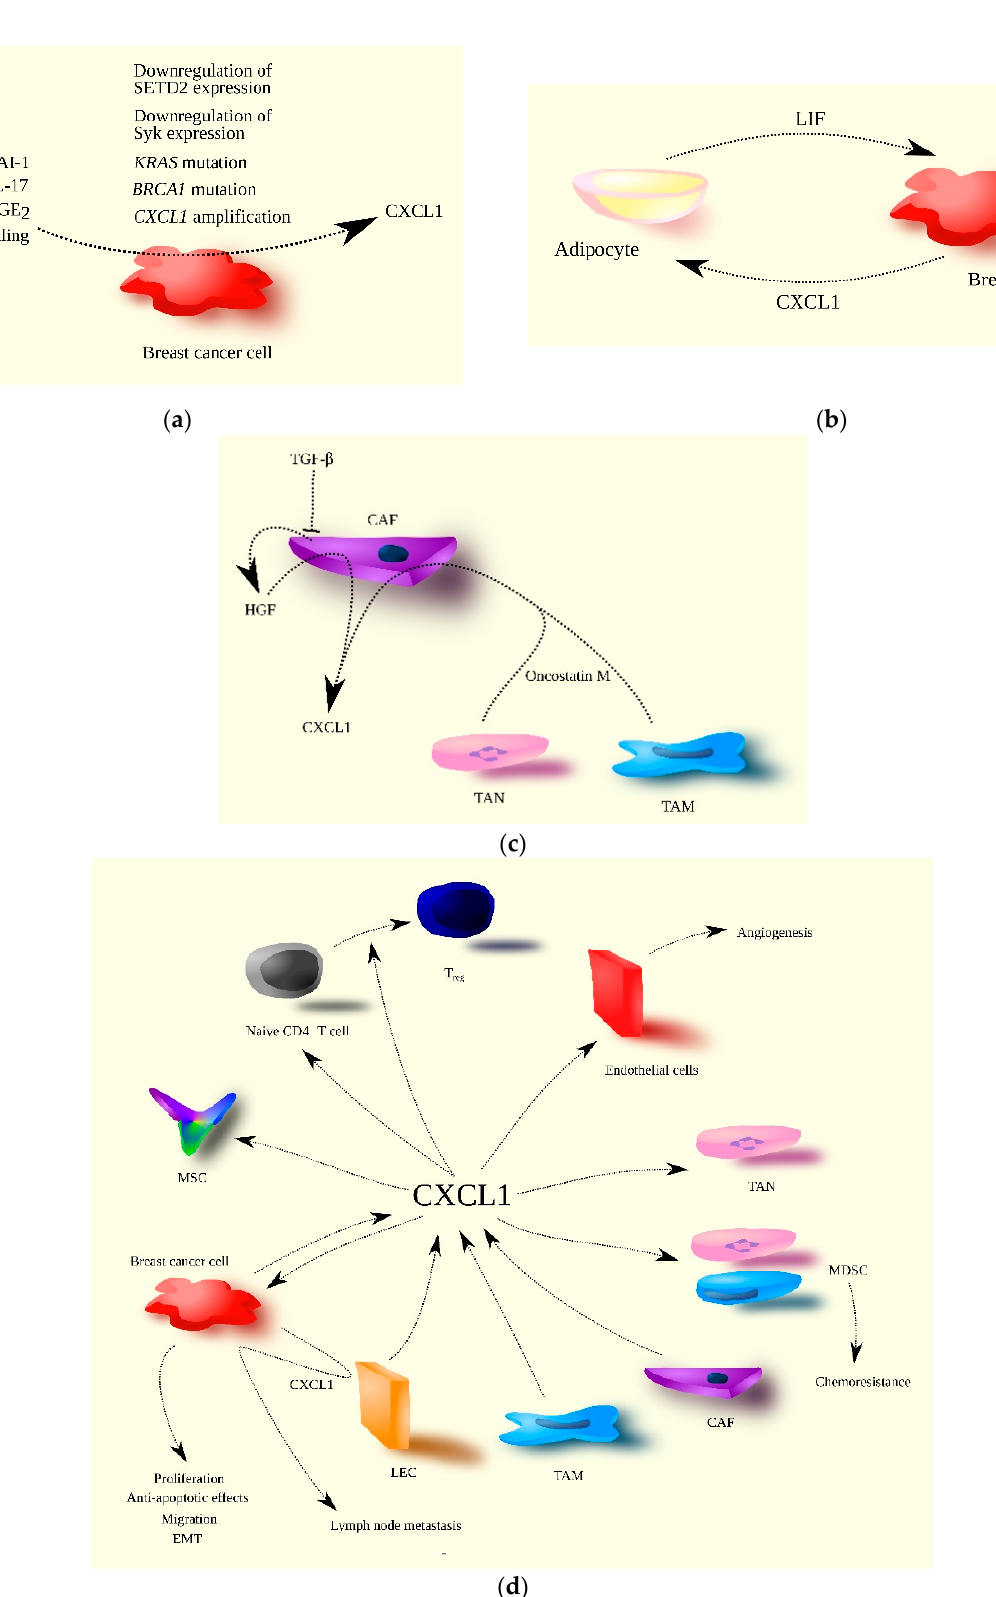
Figure 2. The significance of CXCL1 in breast cancer progression. ( a ) CXCL1 expression is increased in breast cancer cells by both extracellular and intracellular factors. TNF- α , TGF- α (EGFR ligand), PGE2, IL-17, LIF, PAI-1, and Notch signaling are examples of extracellular factors, while mutations in genes such as KRAS and BRCA1 , CXCL1 gene amplification, and the decreased expression of SETD2 and Syk are intracellular factors increasing CXCL1 expression in breast cancer cells. ( b ) The